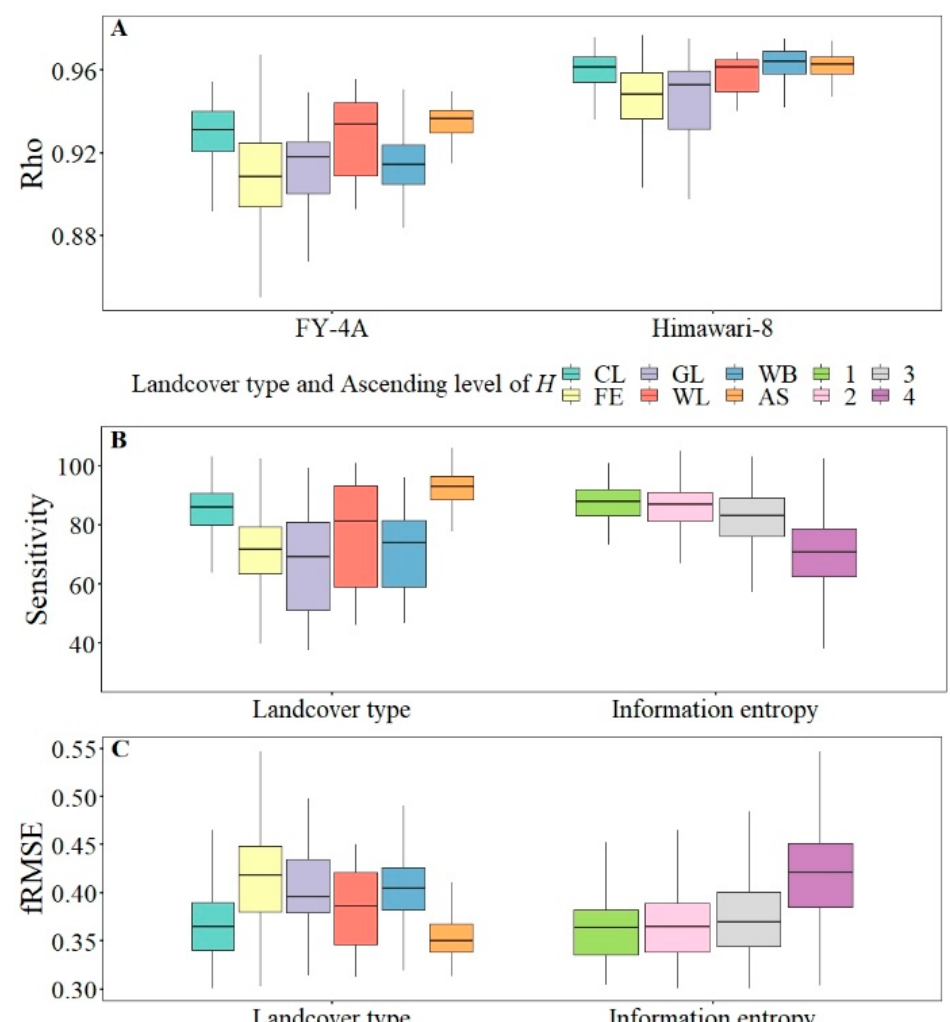
Figure 7. Effect of land cover type and information entropy on the accuracy of remote sensing LST products; abbreviations and FY-4A grids for land cover are: CL Cultivated land (2973 grids), FE Forest (7246 grids), GL Grassland (91 grids), WL Wetland (9 grids), WB Water body (122 grids), AS Artificial surfaces (138 grids); ( A ): Rho vs. land cover type for LST of FY-4A and Himawari-8; ( B , C ) are Sensitivity, fRMSE vs. land cover type and information entropy for FY-4A LST; the number of FY-4A grids in each level of H was 295, 1008, 2650 and 6626.